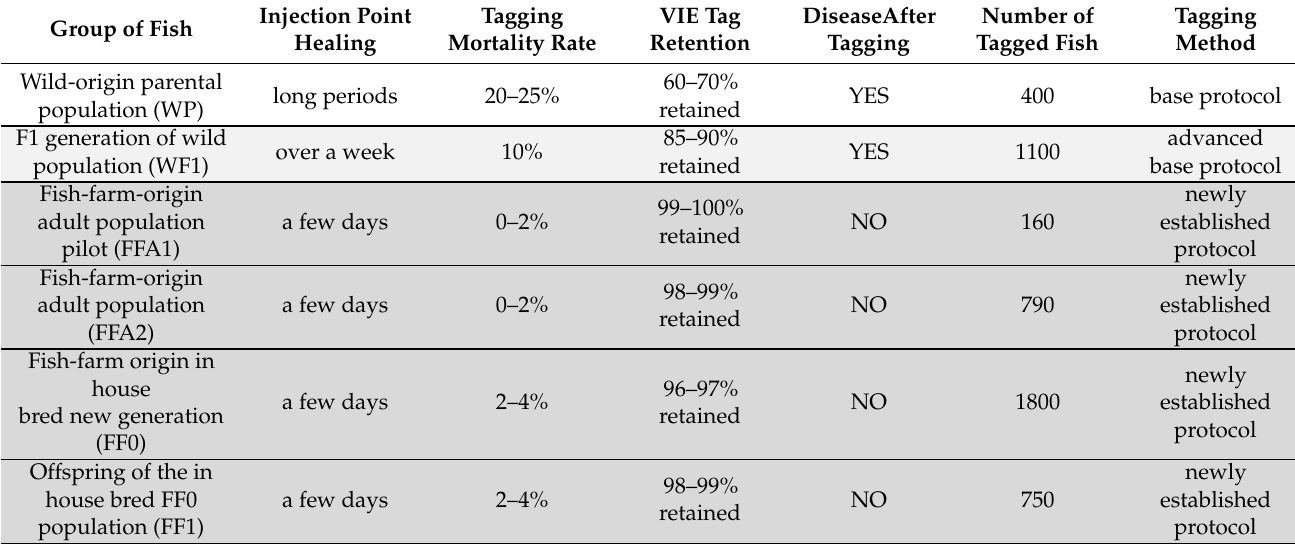
Table 2. Summary of the mortality (health status) and VIE tag retention with the original-base tagging protocol and after with the newly established tagging protocol has been used on the different fish populations. Percentages for mortality and tag retention rates are ranges from data collected across groups of fish tagged on different days. Separately coloured shades used in table highlight the separate tagging